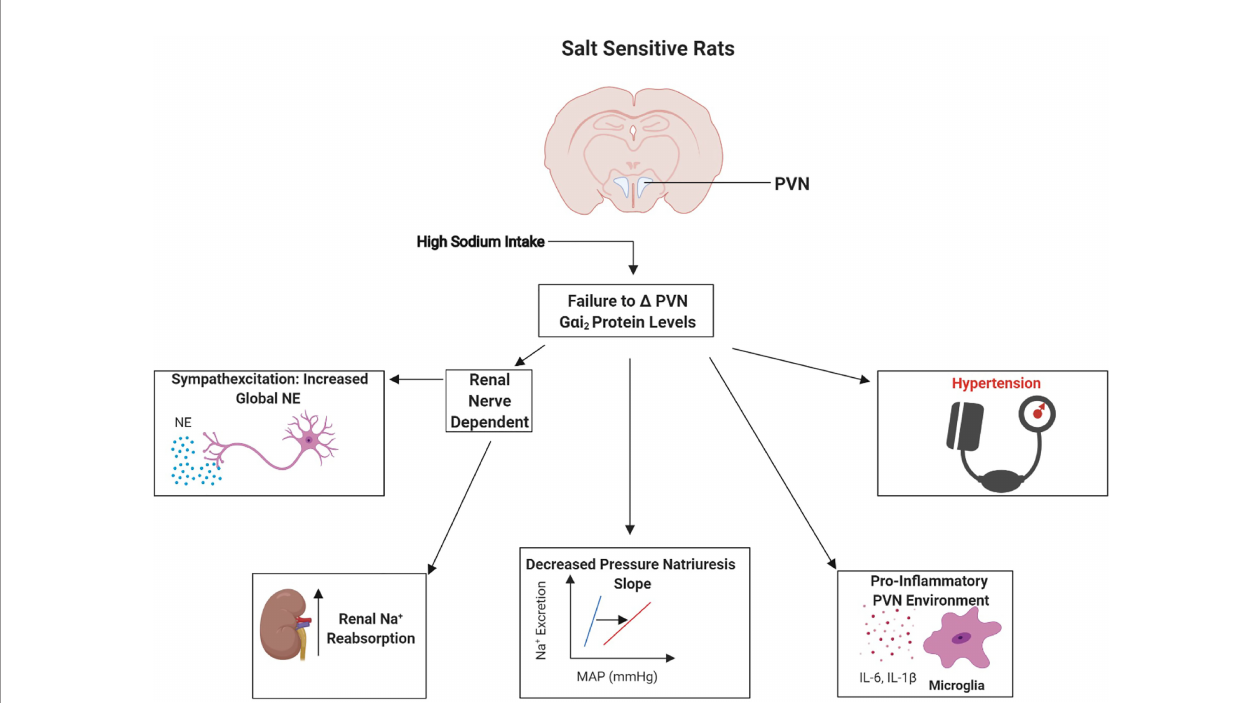
FIGURE 3 | Schematic representation of the proposed physiological role of paraventricular nucleus (PVN) G a i 2 proteins in the development of the salt sensitivity of blood pressure. Failure to upregulate paraventricular nucleus (PVN) G a i 2 proteins in response to elevated dietary sodium intake causes renal nerve-dependent sympathoexcitation, renal sodium retention and neuroin fl ammation resulting in the development of the salt sensitivity of blood pressure. Image was generated using BioRender.